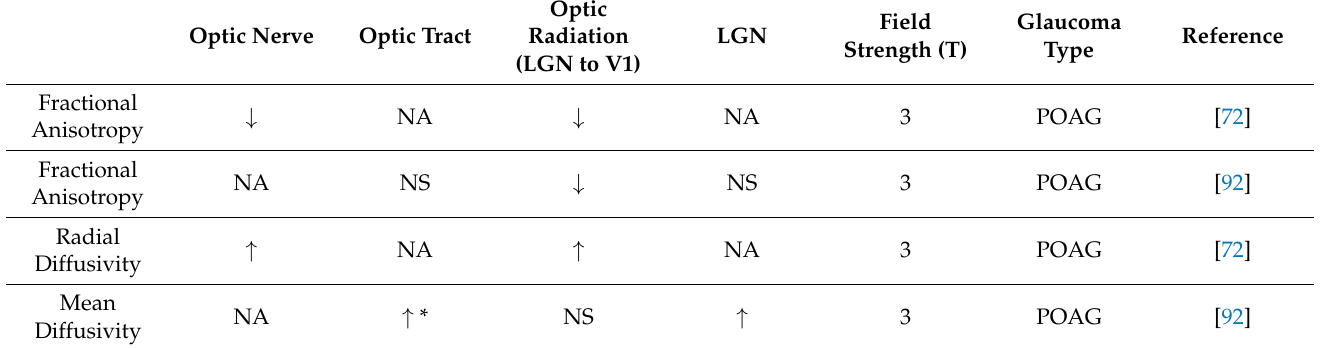
Table 3. Summary of DTI parametric changes across visual brain regions of glaucoma patients rel- ative to healthy control subjects in selected articles. LGN: Lateral geniculate nucleus; V1: Primary visual cortex; POAG: Primary open-angle glaucoma.